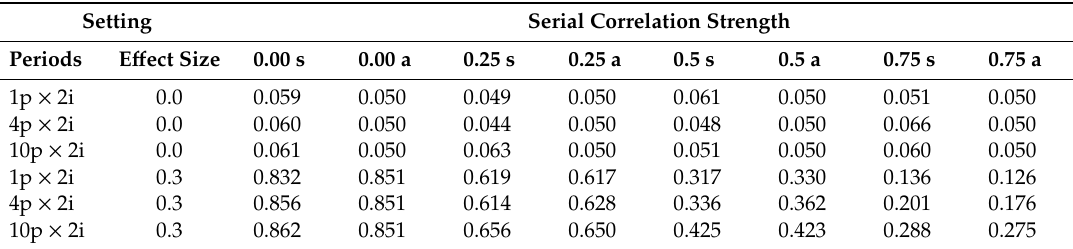
Table 2. Simulation study results investigating the power of N-of-1 designs in comparison to the analytical results reflected in Table